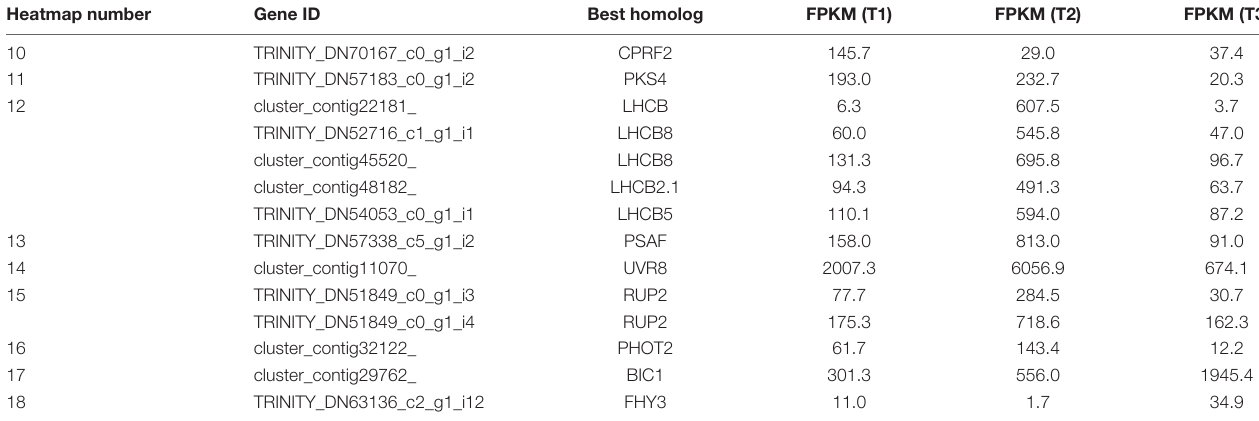
TABLE 2 | Light signaling (corresponding to Figure 3B